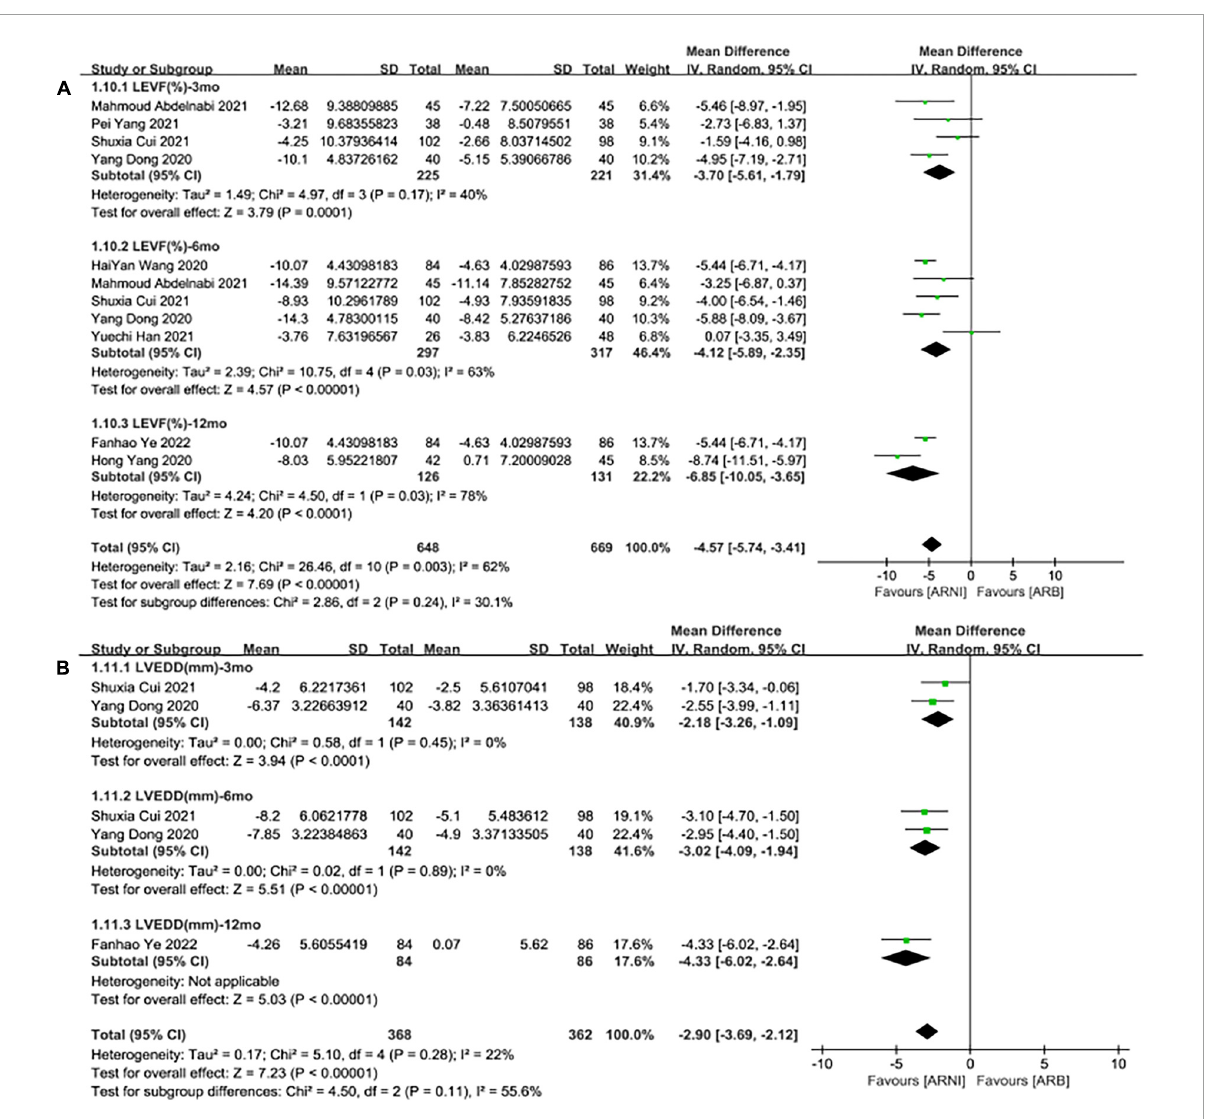
FIGURE6 Subgroup analysis of ARNI effects on CRR indices in contrast with ARBs according to follow-up periods (1). (A) Subgroup analysis on left ventricular ejection fraction, (B) subgroup analysis on left ventricular end-diastolic